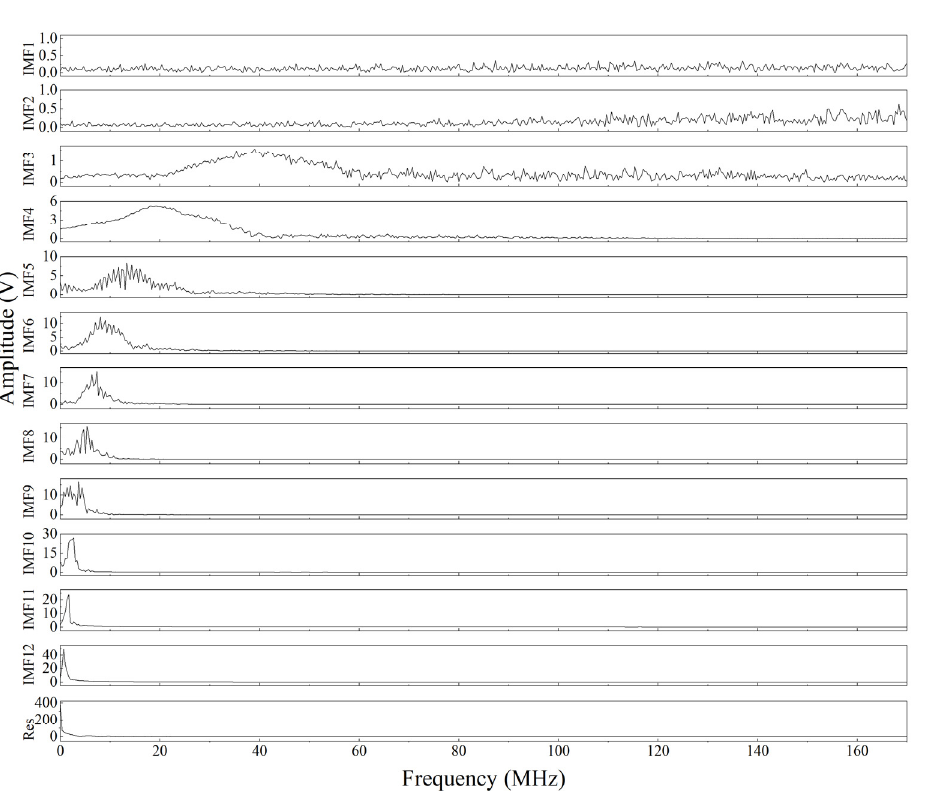
Figure 11. Fourier transform of the IMFs decomposed by the EMD method for the ultrasonic signal.